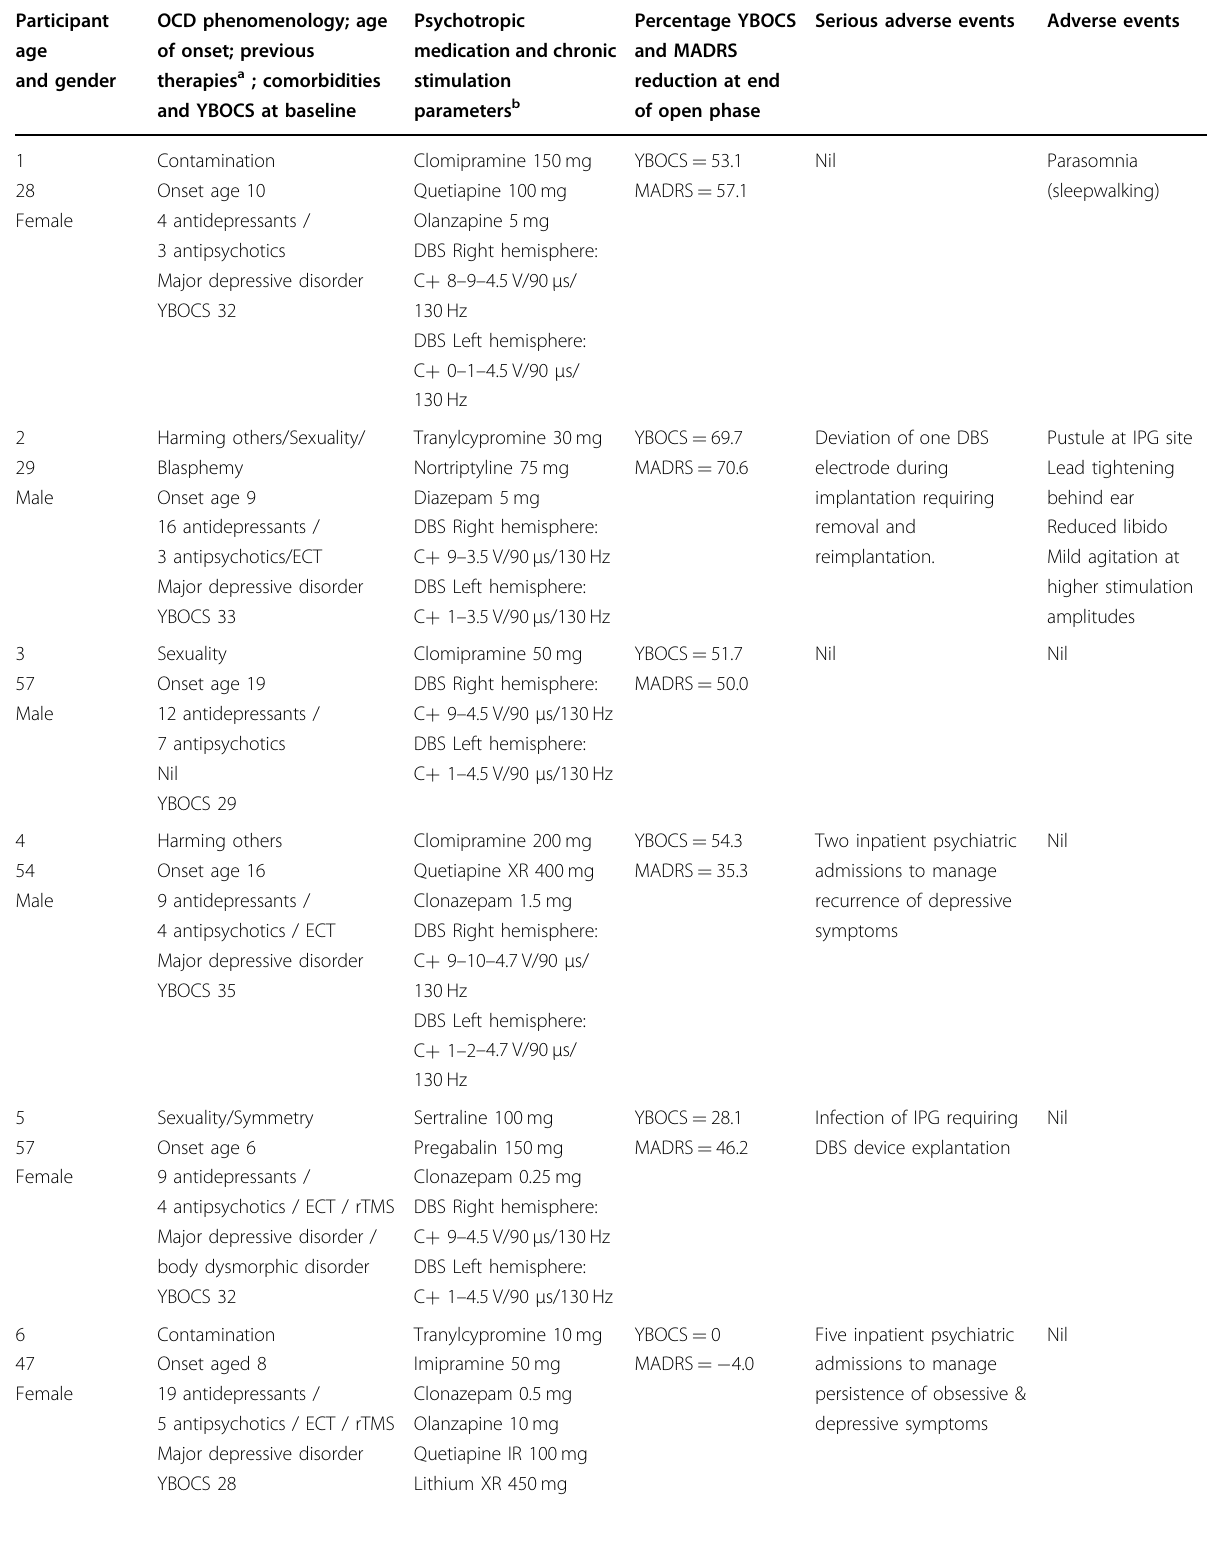
Table 1 Details of